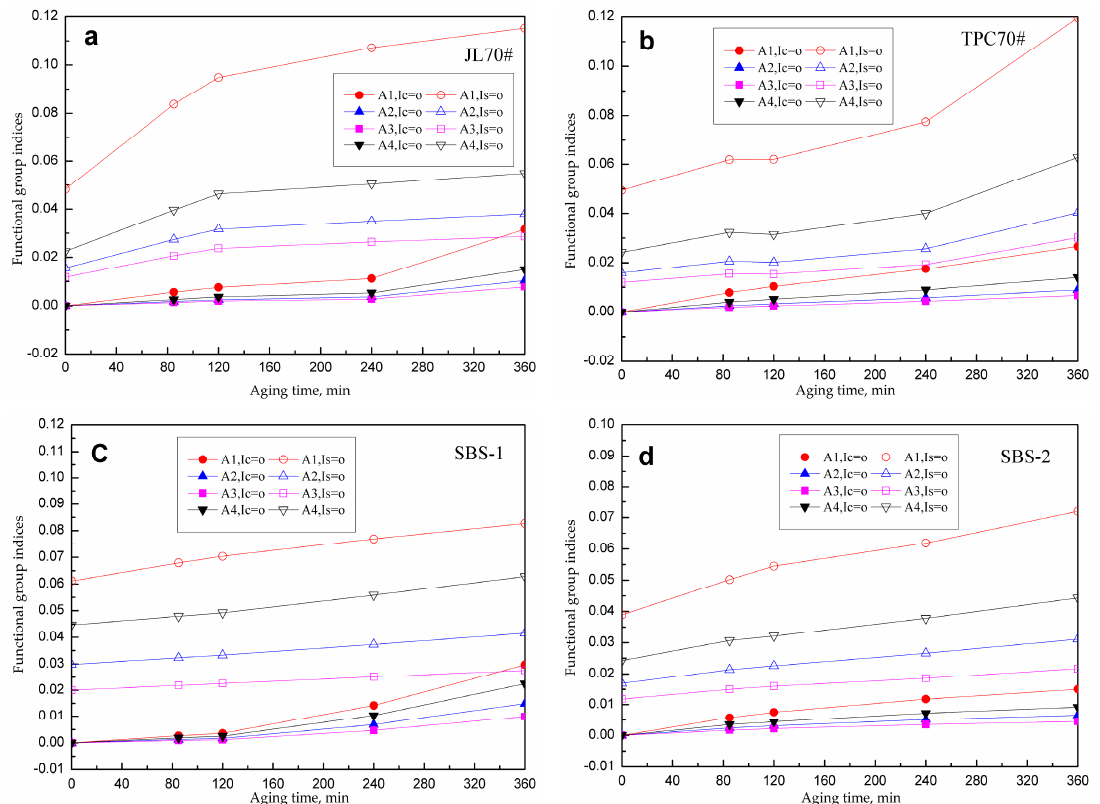
Figure 5. The changing trend of the carbonyl and sulfoxide functional group indices of all asphalt samples. ( a ) JL70#; ( b ) TPC70#; ( c ) SBS-1; ( d ) SBS-2.